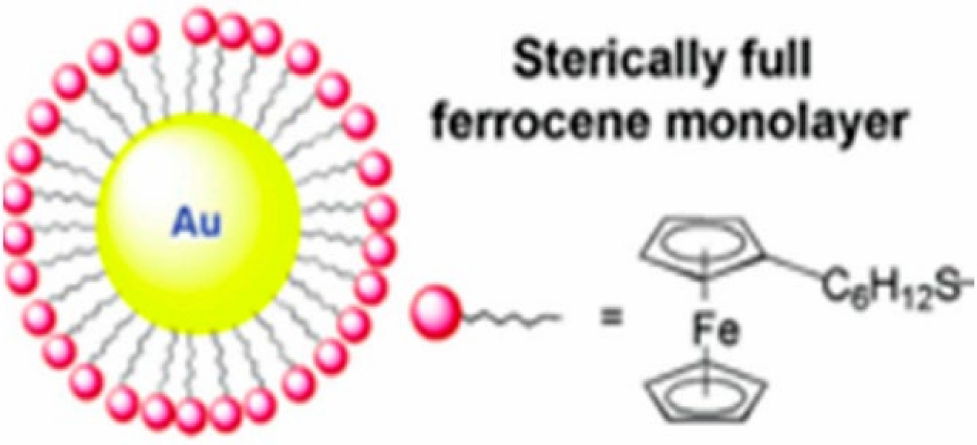
Figure 11. Typical thiophenol ferrocene scheme, replicated by reference authorisation, ACS, 2007